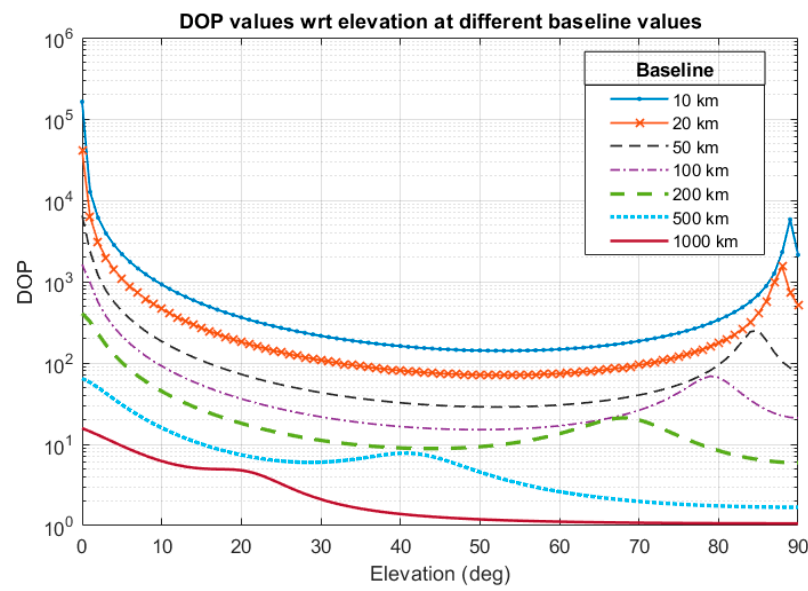
Figure 3. DOP trend with respect to elevation (for different baseline values).